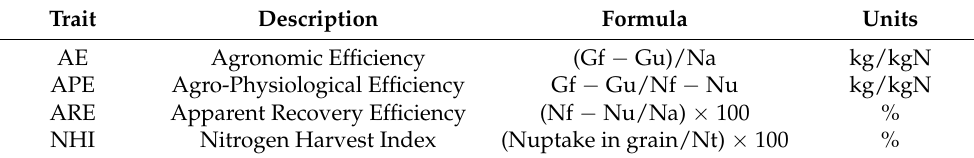
Table 1. Nitrogen use efficiency component. Trait Description